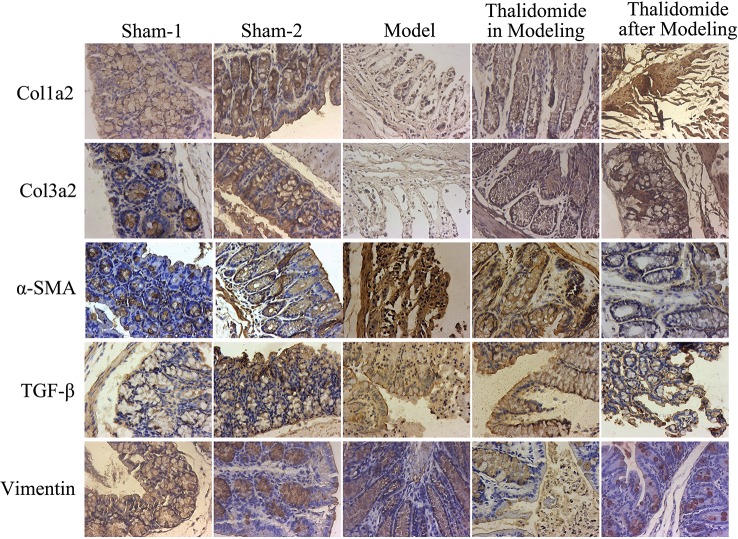
Immunohistochemical assay was performed to evaluate the expression levels of fibrosis-related proteins in mice from different groups. TNBS induction could significantly increase the expressions of col1a2, col3a2, TGF-β and α-SMA while decrease the expression of Vimentin, and thalidomide treatment could reverse the phenomenon.